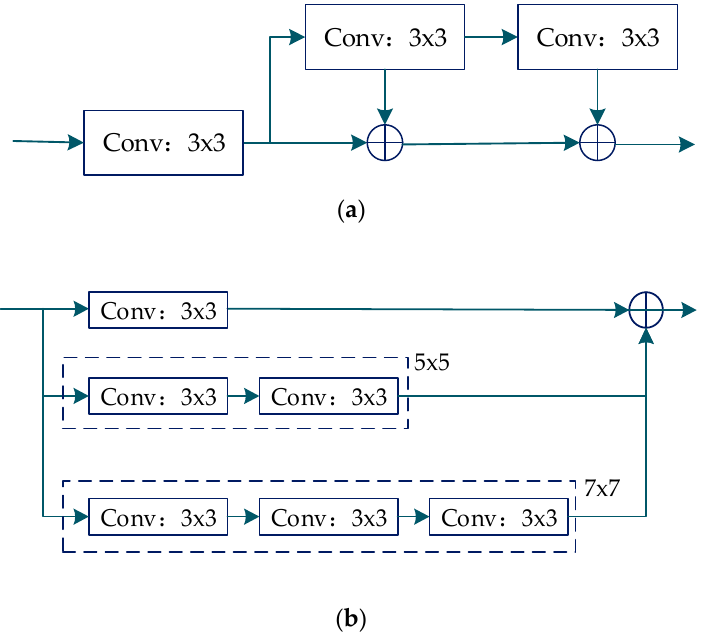
Figure 8. Multiscale convolution kernel was achieved through series and parallel convolution kernels. ( a ) A schematic diagram of the multiscale convolutional structure advanced in this paper; ( a ) is equivalent to ( b ).